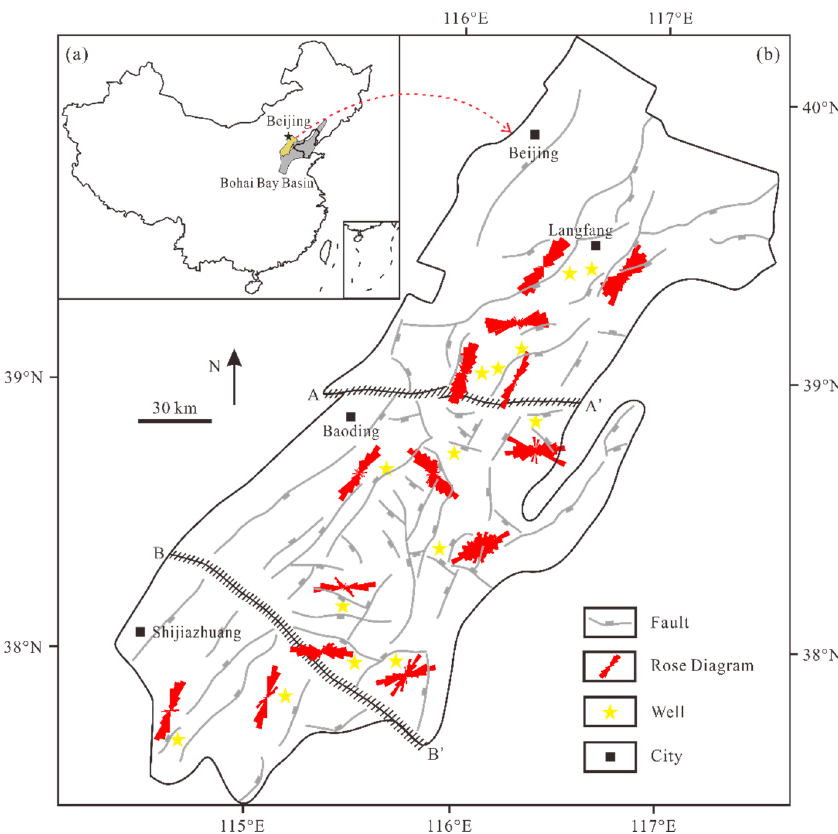
Figure 17. The relationship between fault and fracture strikes. ( a ) Location of the Jizhong Sub-Basin in the Bohai Bay Basin in China (modified from Zhao et al., 2015) [9]. ( b ) Faults and tectonic fracture orientations in the carbonate rocks of the Jizhong Sub-basin. The fault data was modified from the Huabei Oilfield database. The data regarding fracture orientations is derived from the borehole image logs of 14 wells.